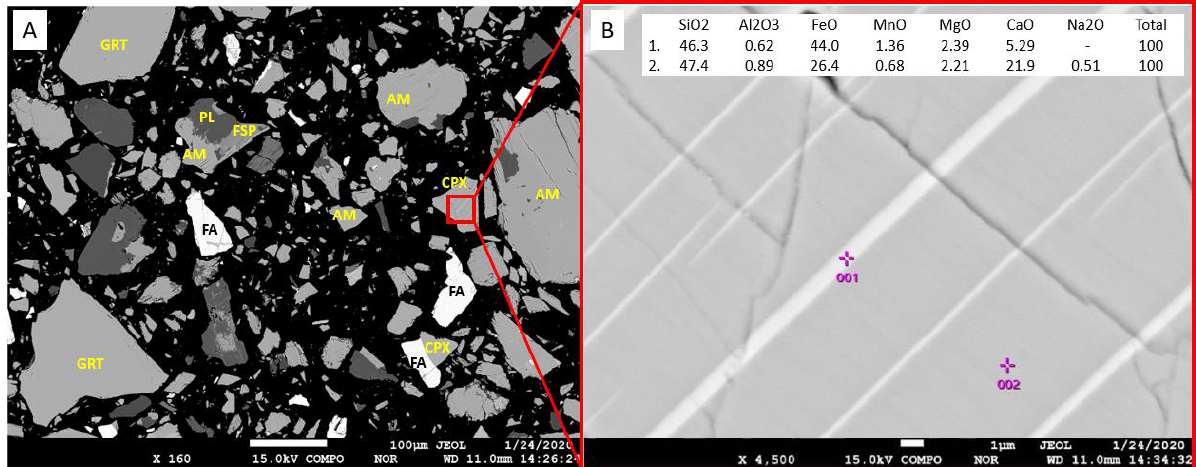
Figure 8. ( A ) Back-scattered electron image of SLon R2/l_2 concentrate. Abbreviations: AM = amphibole; CPX = clinopyrox-